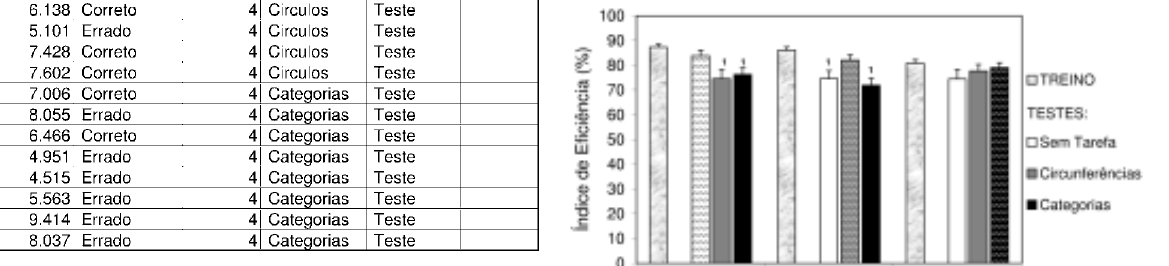
Figura 2. Informações coletadas e armazenas no arquivo *.csv para cada participante submetido ao experimento de DRL.